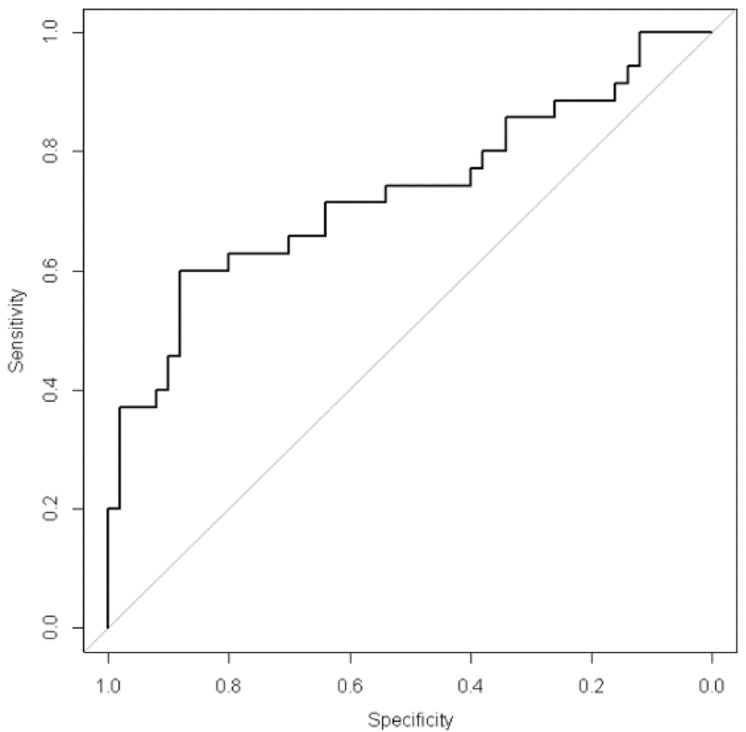
area under the curve = 0.73 [0.66 – 0.87], sensitivity = 60%, specificity =